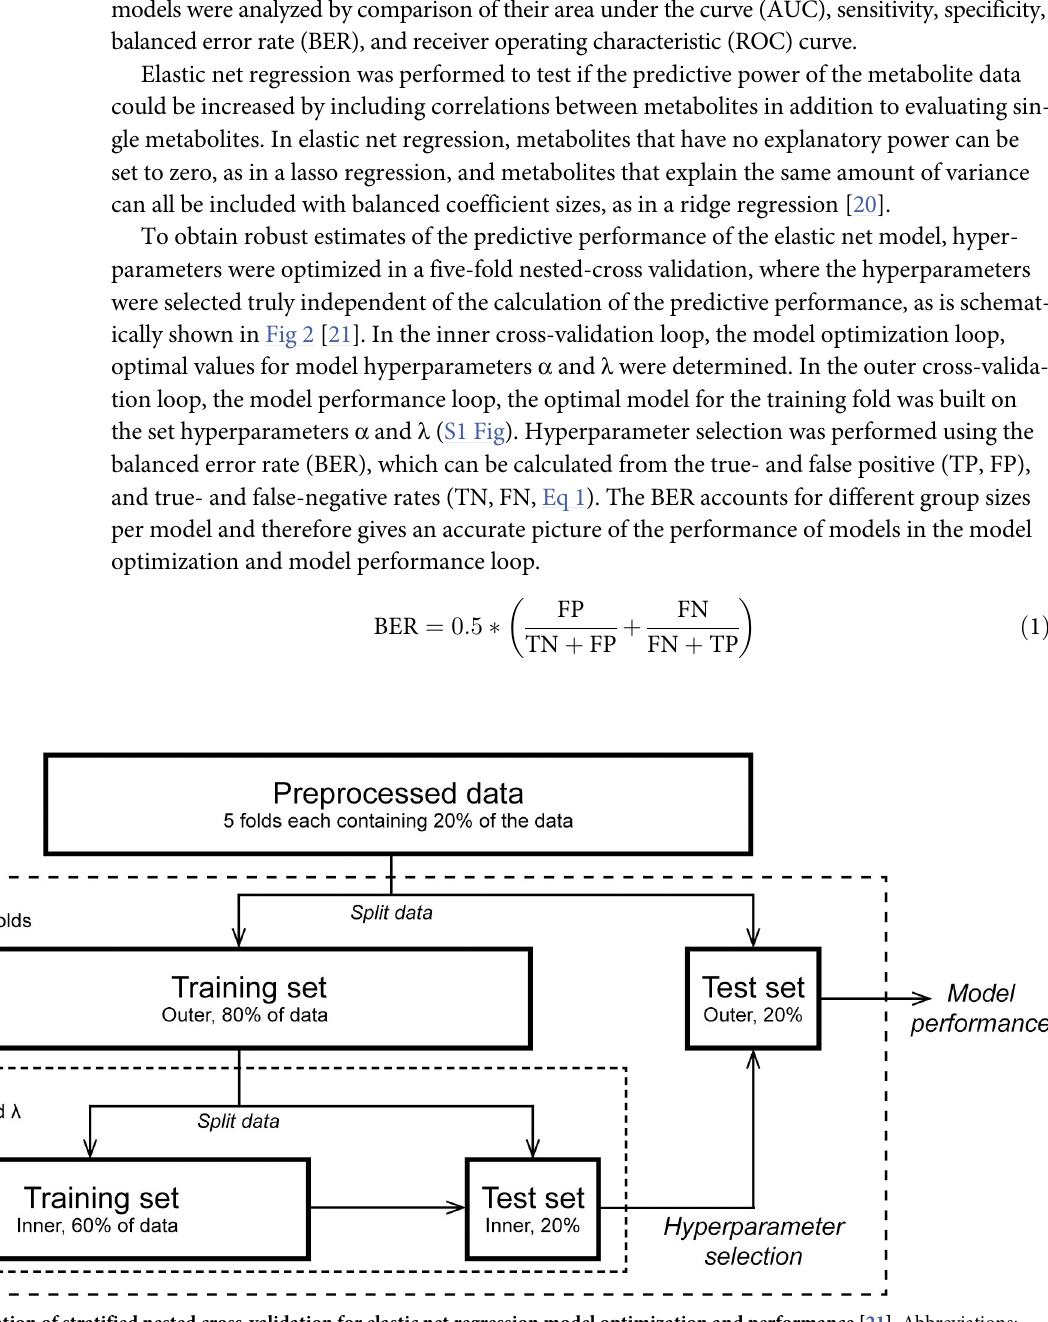
PLOS ONE | https://doi.org/10.1371/journal.pone.0252378 June 4,